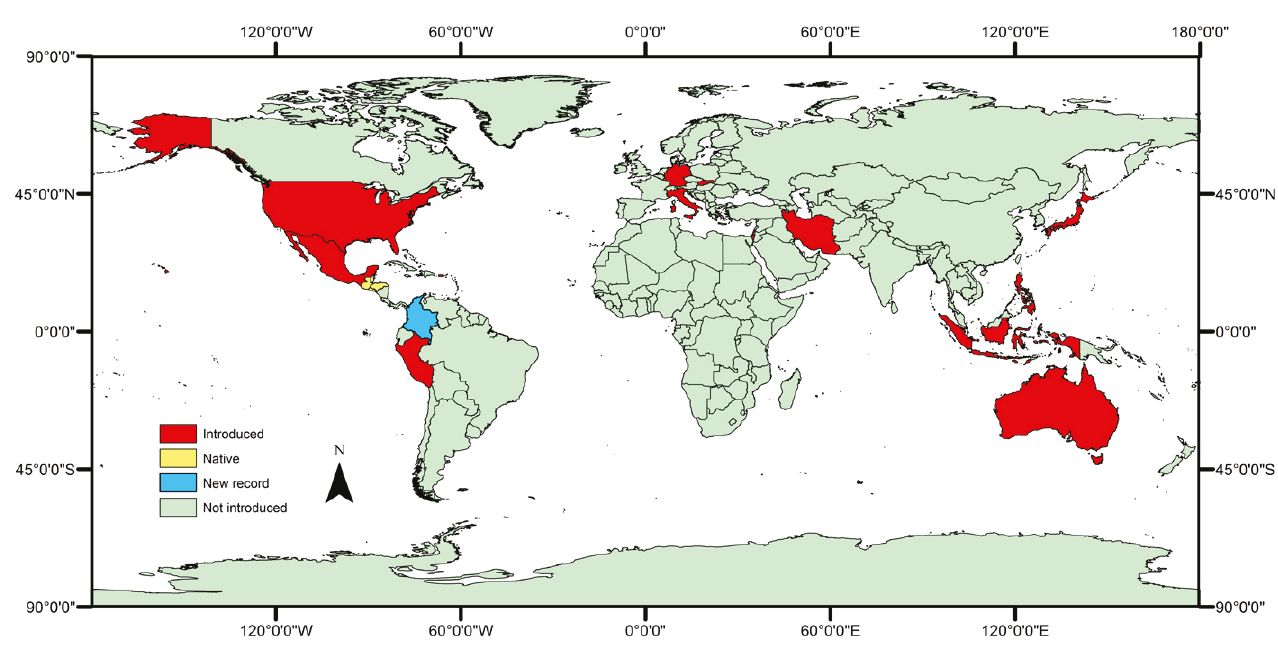
Figure 8: Current distribution of A . nigrofasciata at country level based on records reported on